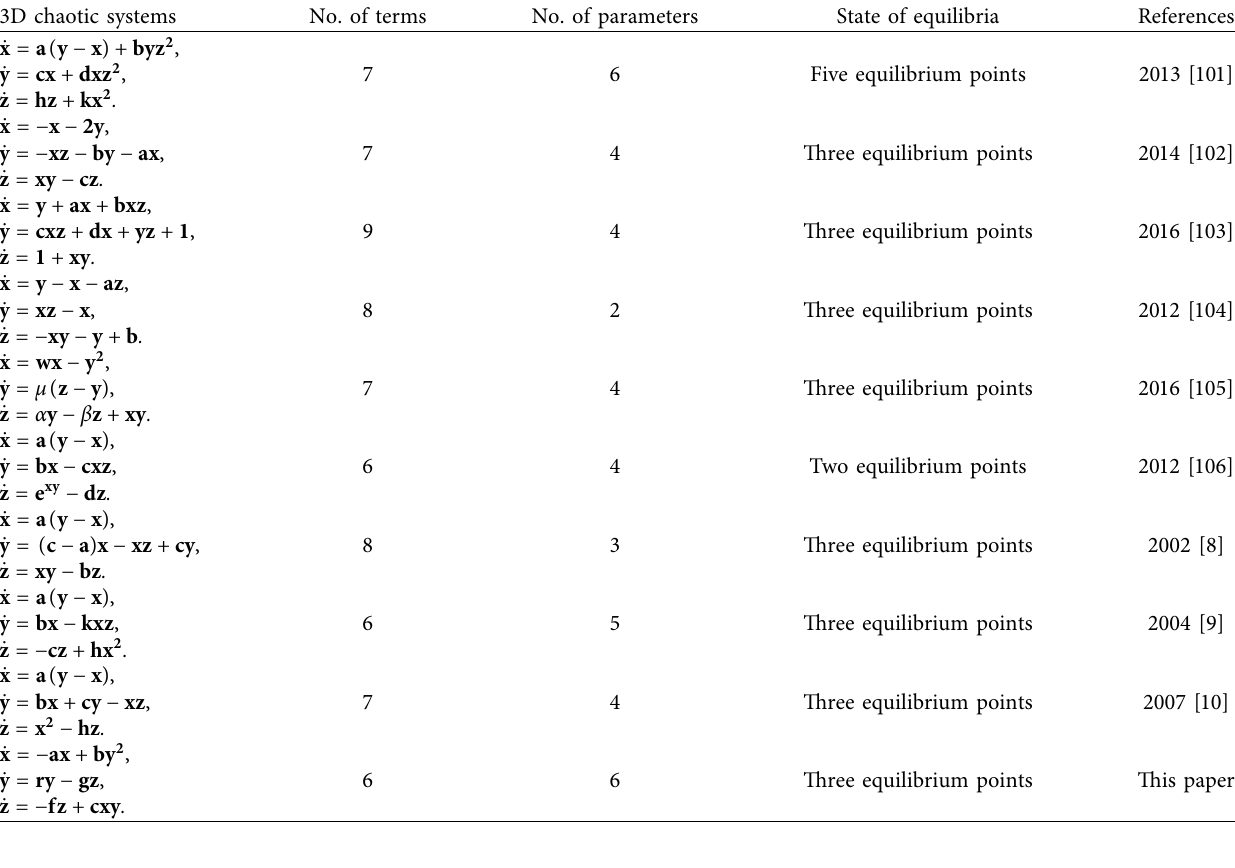
Table 1: Categorization of the diferent 3D-chaotic